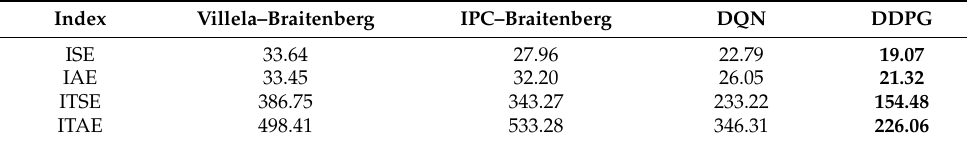
Table 5. Performance indices for the environment with